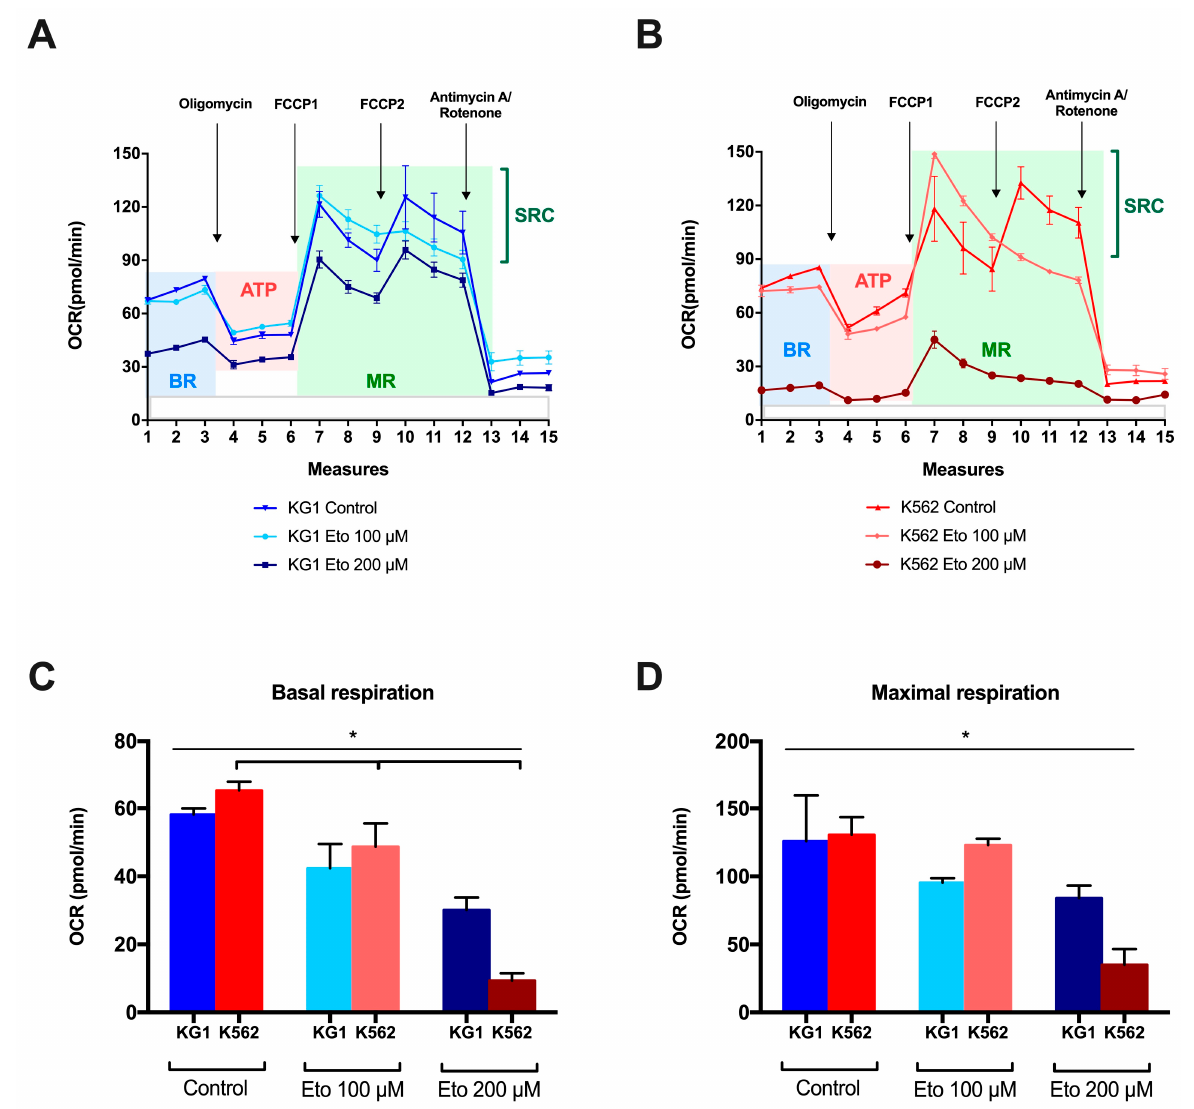
Figure 5. Variation in the respiratory profiles of the two cell lines KG1 and K562 at 24 h of culture. The profiles of the key parameters of KG1 ( A ) and K562 ( B ) in their basal state, and with increasing concentrations of etomoxir (100 and 200 μ M) are presented, as are the OCR variations in basal respiration ( C ) and maximal respiration ( D ). * p < 0.05. Abbreviations: ATP: adenosine triphosphate,